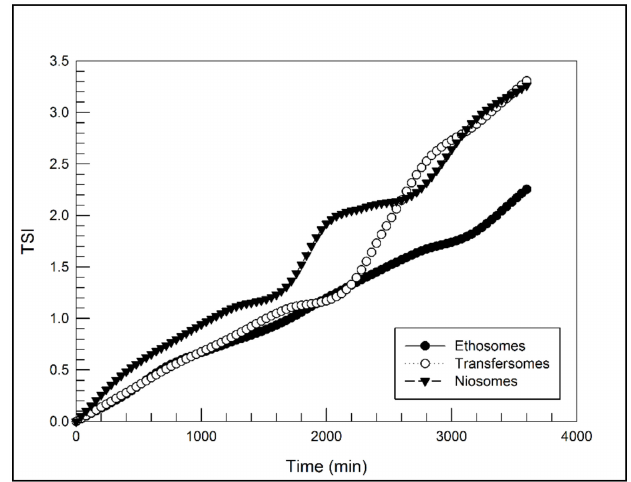
Figure 2. Turbiscan Stability Index (TSI) in function of time obtained for ethosomes, transfersomes and niosomes, by using Turbiscan Lab ®